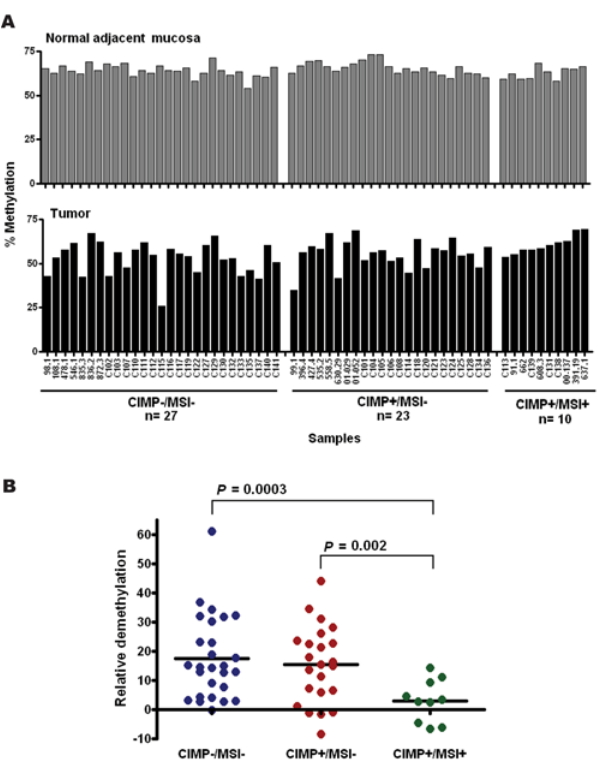
Figure 2. Differential LINE-1 methylation among CIMP/MSI groups in primary colorectal carcinoma samples (CRCs). A) Colorectal tumor DNA and their normal appearing adjacent mucosa from sixty patients were evaluated for LINE-1 methylation. These tumors were previously evaluated for CpG island methylator phenotype (CIMP), using a panel of single-copy genes methylation analysis, and microsatellite instability (MSI) status, resulting in the identification of three CIMP/MSI groups. In normal appearing mucosa (top) little variation in LINE-1 methylation is observed between samples and CIMP/MSI groups (average methyla- tion=64.3%), while in tumor (bottom) several samples undergo high LINE-1 demethylation (25/60 tumor samples have methylation density bellow 55%), most notable in CIMP + /MSI-and CIMP-/MSI-groups. B) Relative LINE-1 demethylation in CRCs. Relative demethylation was calculated as the percent change of LINE-1 methylation in tumor compared to its normal appearing mucosa. Both CIMP + /MSI-and CIMP-/ MSI-samples presented in average 16% demethylation for LINE-1, while no significant changes were observed for the CIMP + /MSI + samples. For the CIMP + group, 4–9% increase of methylation density for LINE-1 was observed for a small fraction of samples, most of them identified as CIMP + /MSI +